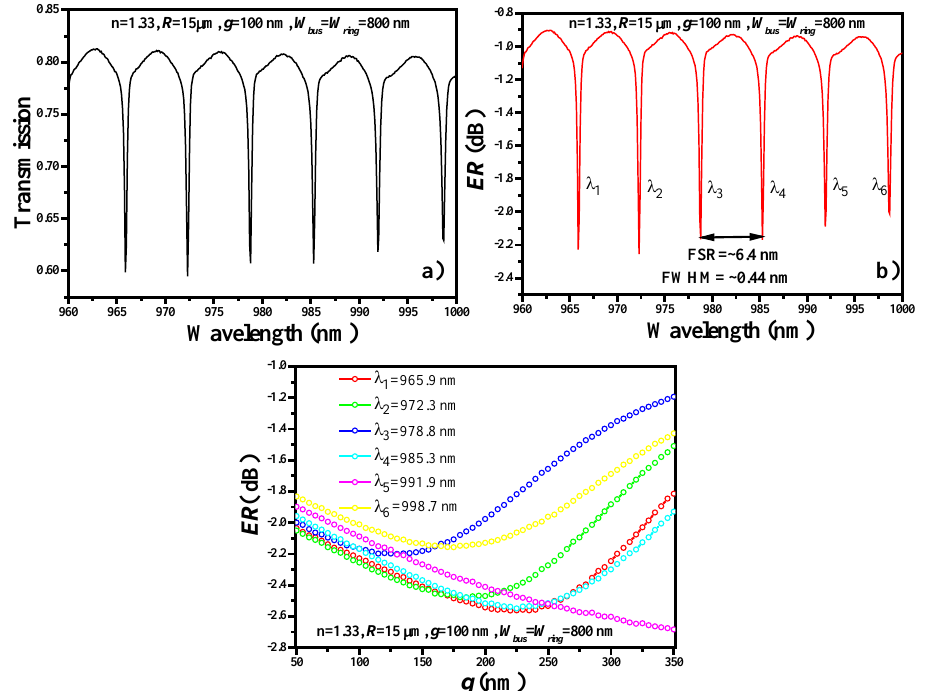
Figure 11. Spectral characteristics of the RR structure: ( a ) transmission spectrum, ( b ) FSR versus ER, ( c ) optimization of g . Geometric parameters such as R = 15 µm, g = 100 nm, W bus = W ring = 800 nm and n = 1.33 are used.